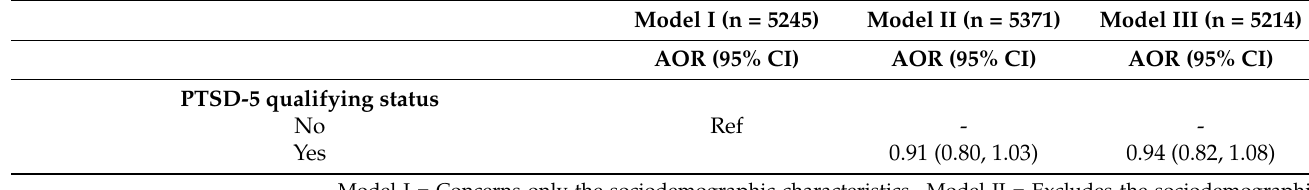
Model I = Concerns only the sociodemographic characteristics. Model II = Excludes the sociodemographic characteristics. Model III = Combines Models I and II. The models were based on complete case analysis. AOR = Adjusted odds ratio. CI = Confidence interval. Ref = Reference GAD-2 = Generalized Anxiety Disorder. PHQ-2 = Patient Health Questionnaire-2. PHQ-4 = Patient Health Questionnaire-4. PTSD =